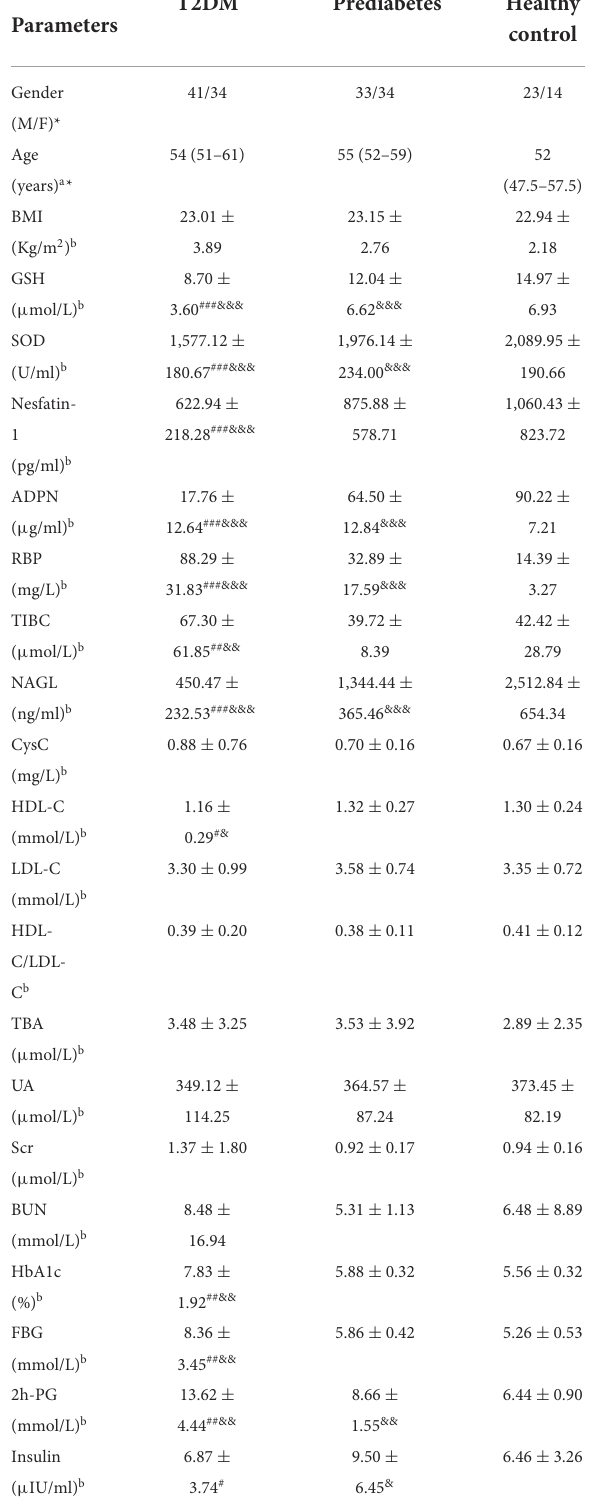
TABLE 1 Anthropometric and clinical characteristics of the study subjects in different